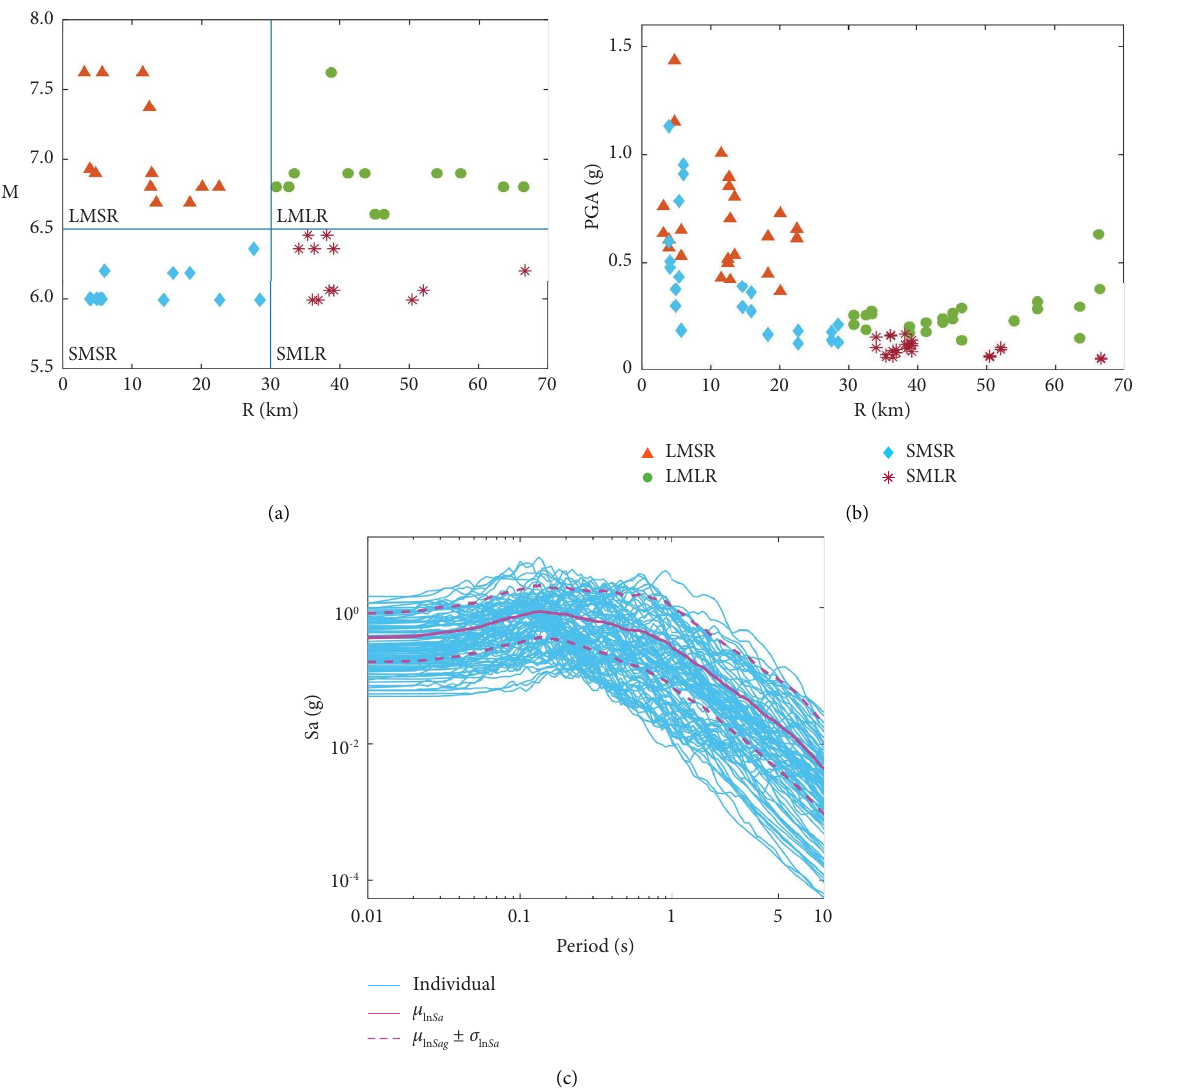
Figure 5: Characteristics of selected ground-motion records: (a) M-R distribution, (b) PGA -R distribution, and (c) spectral acceleration with 5% damping